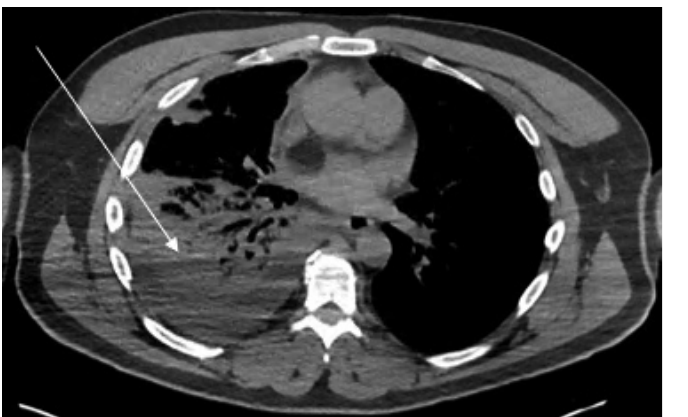
chest. Arrow pointing at multilobular atelectasis and pleural effusion.